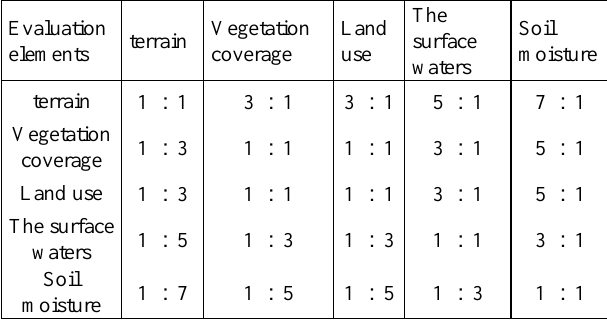
Table 2 Comparison scale of each evaluation element